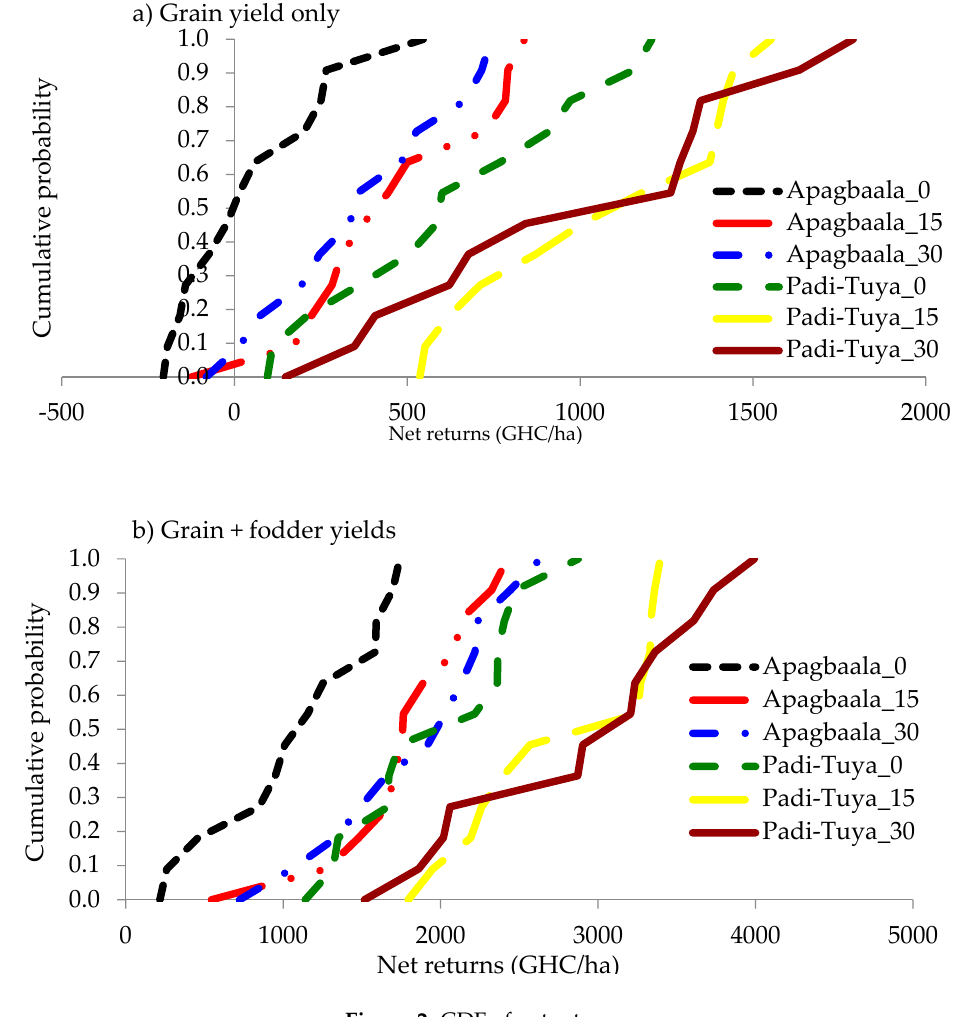
Figure 2. CDF of net returns.